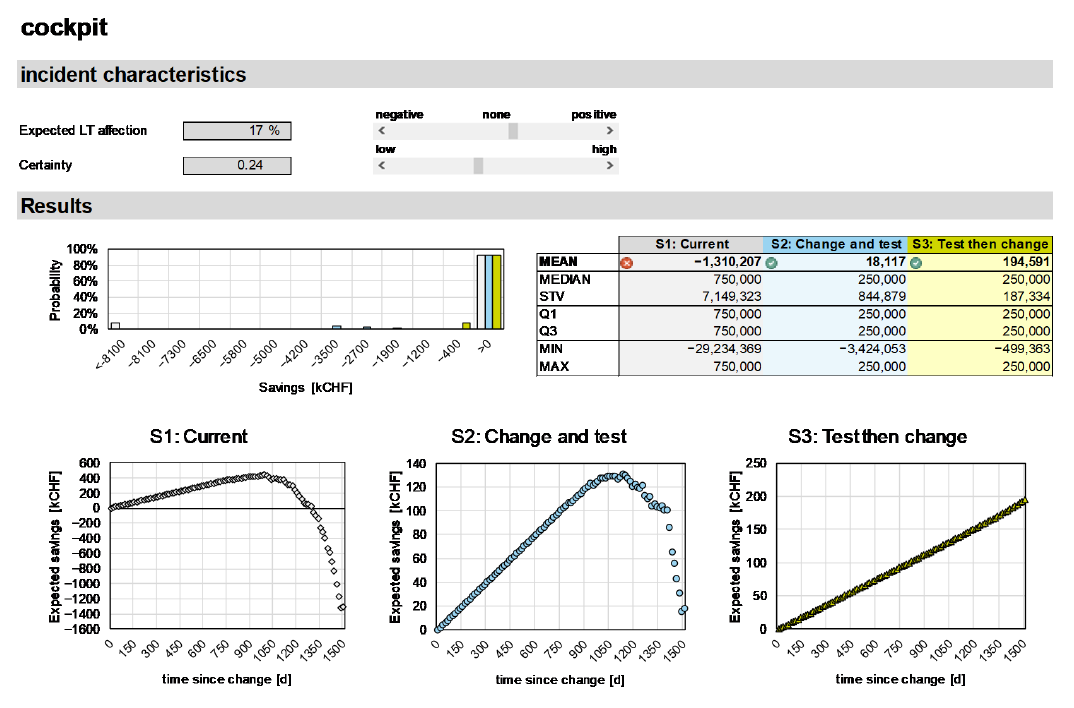
Figure 5. Implemented risk assessment tool for the three switching strategies. Table 2. Results of the risk-assessment tool application on the use-case. k